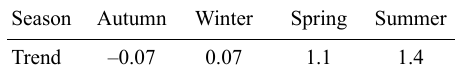
Fig. 1. Average monthly rainfall (mm) for the period 1912 to